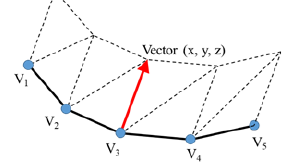
Figure 13. Data size minimization for basic type faces.